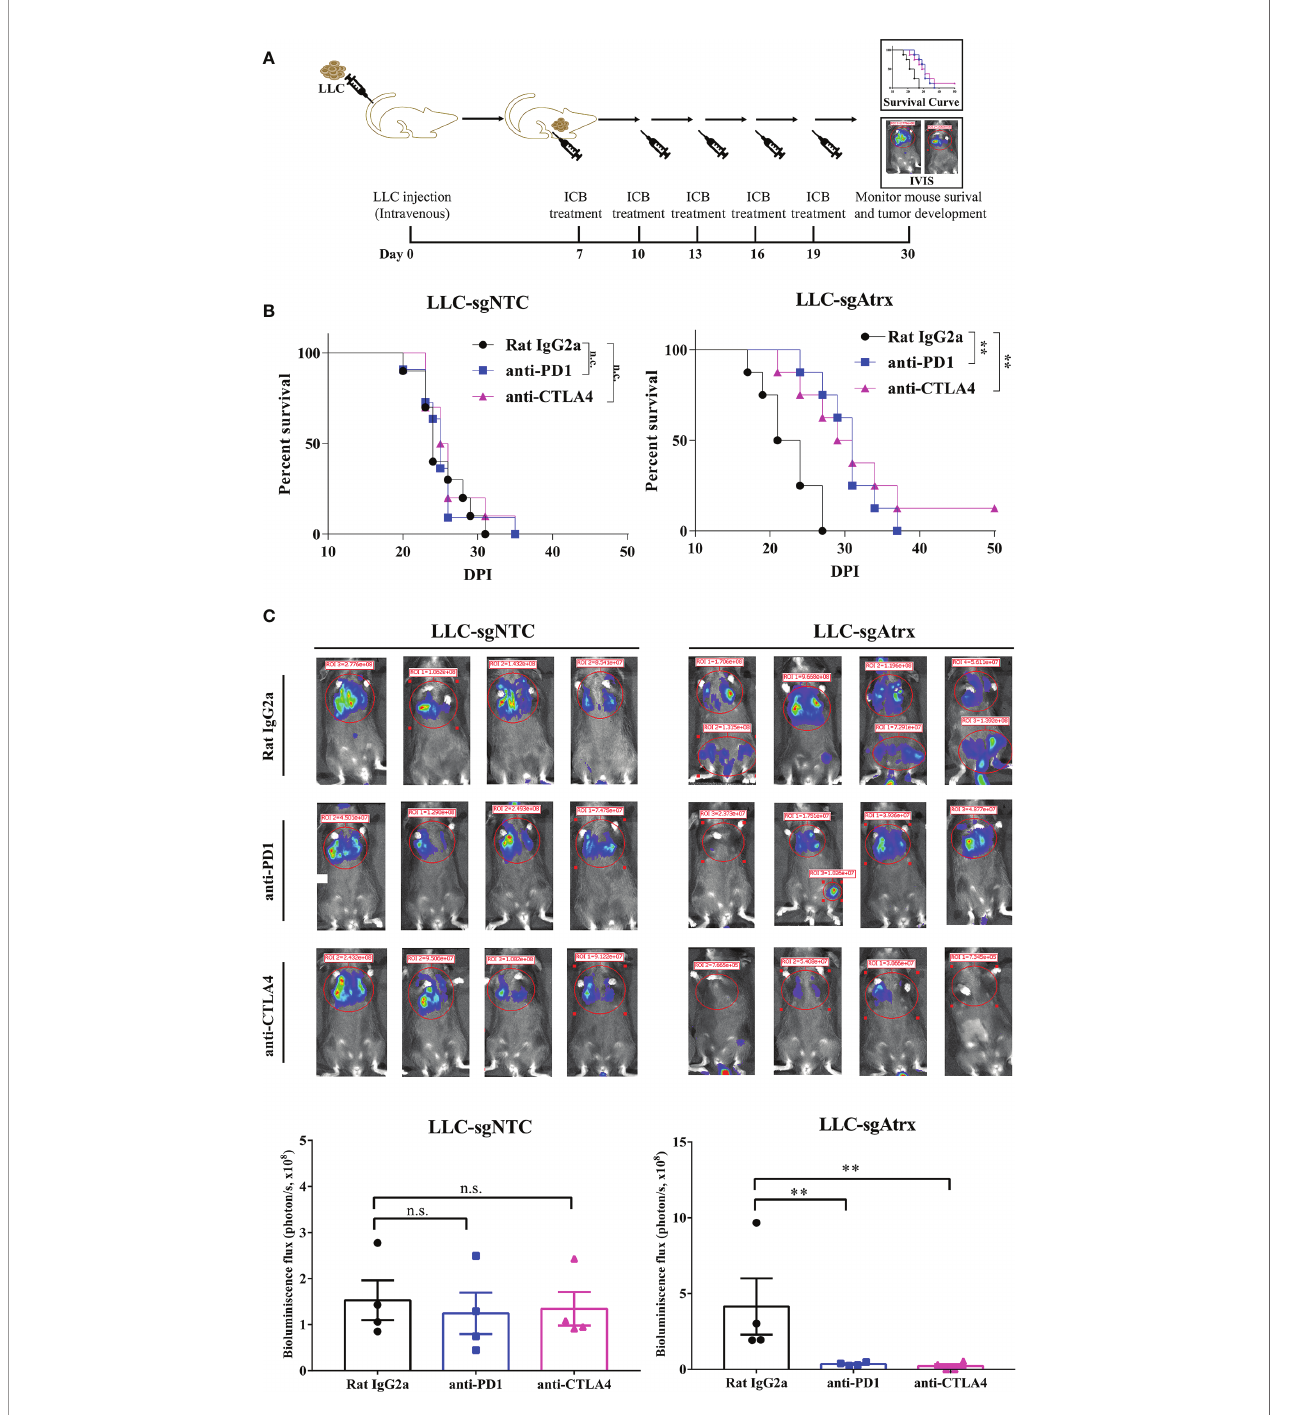
FIGURE 4 | Atrx de fi ciency sensitizes NSCLC to ICI treatment in orthotopic mouse model. (A) experimental design for establishment of the orthotopic mouse model by intravenous seeding of tumor cells to analyze the tumor burden in vivo . (B) Kaplan-Meier survival curves of mice bearing LLC tumors with and without Atrx de fi ciency after anti-PD1 or anti-CTLA4 treatment. Neither aCTLA4 (n = 4) nor aPD1 (n = 4) treated mice showed a signi fi cant survival difference in Atrx-expression mice, compared with control group (n = 4) ( P = 0.9341, 0.9412). Both aCTLA4 (n = 4) and aPD1 (n = 4) treated mice showed a signi fi cant survival difference in Atrx- de fi cient mice, compared with control group (n = 4) ( P = 0.006, 0.003). (C) The luciferase signals detected by IVIS in mice bearing LLC generated tumors with and without Atrx de fi ciency after ICI or isotype antibody treatment. Neither aCTLA4 (n = 4) nor aPD1 (n = 4) treated mice showed a signi fi cant signal difference in Atrx- expression mice, compared with control group (n = 4) ( P = 0.8521, 0.7644). Both aCTLA4 (n = 4) and aPD1 (n = 4) treated mice showed a signi fi cant signal difference in Atrx-de fi cient mice, compared with control group (n = 4) ( P = 0.005, 0.002). **P<0.01. n.s., not signi fi